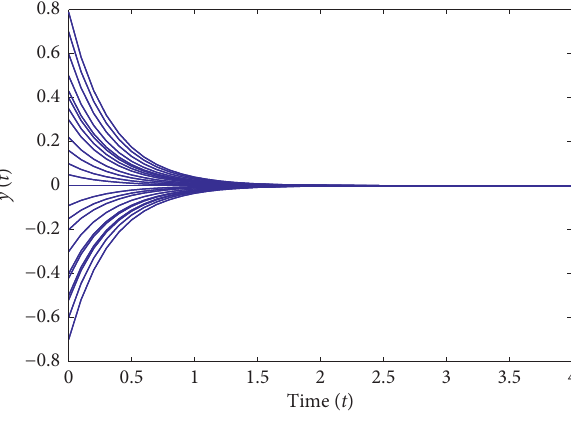
Figure 2: Stable behavior of y